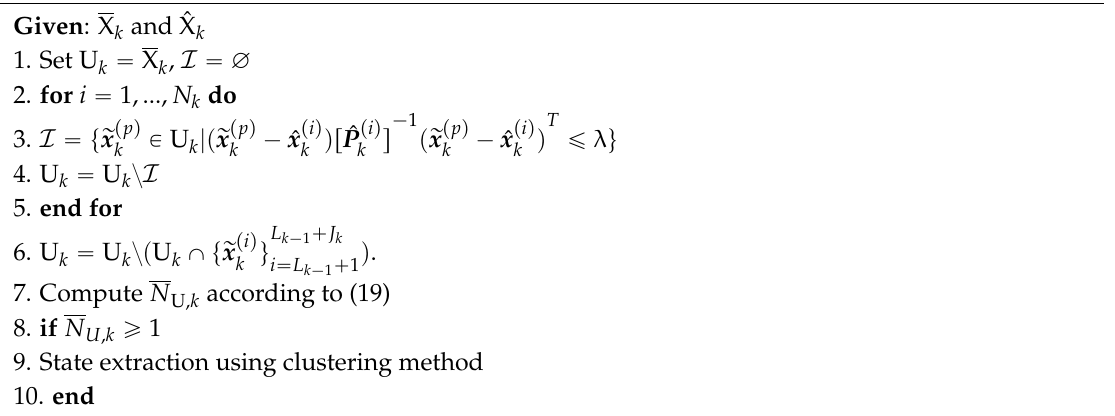
Algorithm 2. Methods for state estimation of undetected